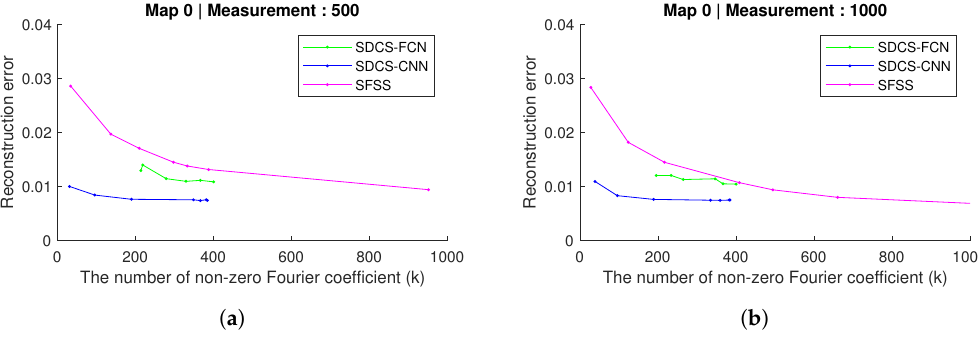
Figure 11. When the distances of two adjacent subgoals are 20, the figure shows the k-sparse in transferred coefficient vs. mean error between reconstructed result and ground truth in Map-0 and two different numbers of measurements. The reconstruction resulted in 500 and 1000 measurements in Map-0 (Figure